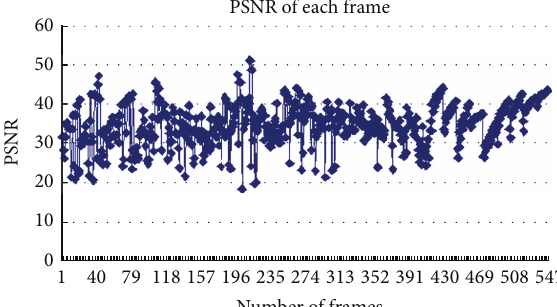
Figure 2: Each frame PSNR value of akiyo video